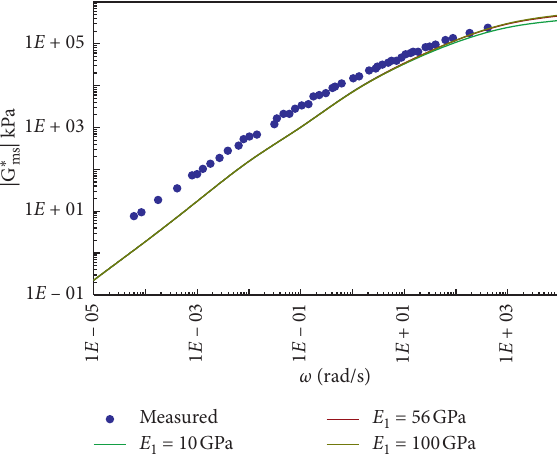
Figure 11: Effect of modulus of fillers on predicted | G ∗